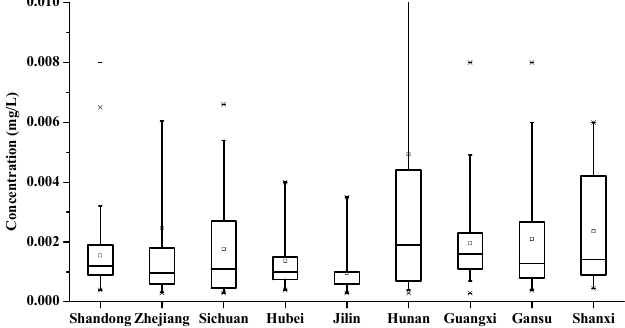
Figure 7. Boxplot of discharge concentrations of As from different regions WWTPs. “ (cid:3) ” stands for average value, and “ × ” stands for 95%